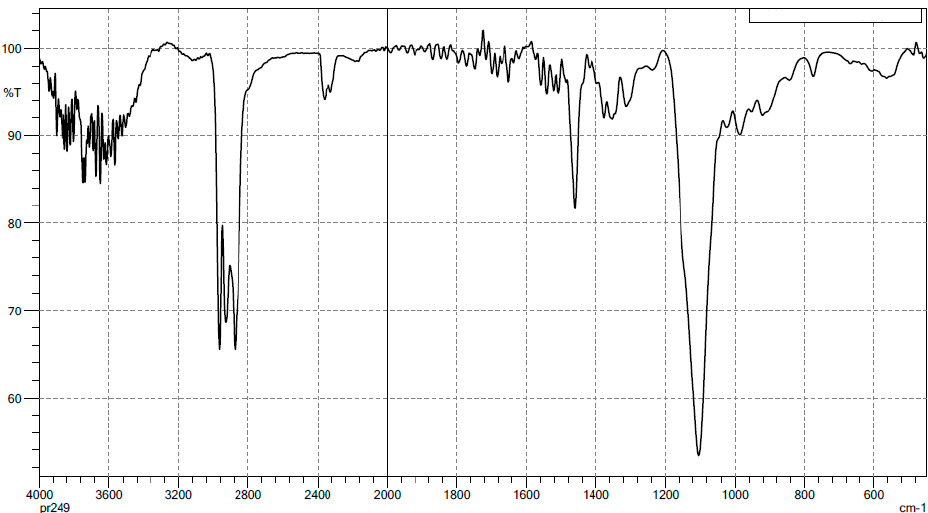
Figure 5. MALDI-TOF spectrum of PBO-diol (4) obtained with K-DPG / L.